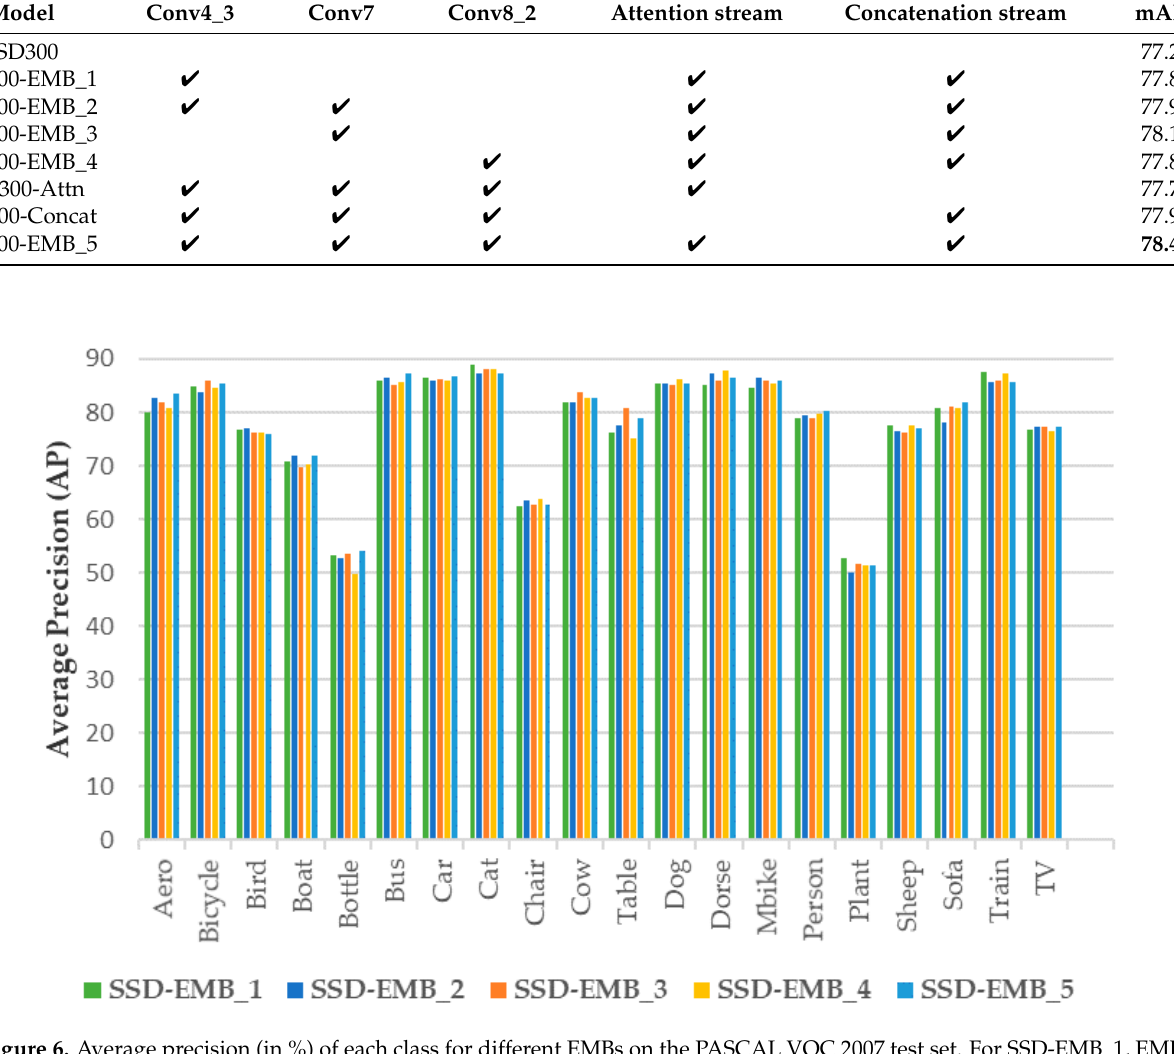
Figure 6. Average precision (in %) of each class for different EMBs on the PASCAL VOC 2007 test set. For SSD-EMB_1, EMB was applied to Conv4_3. For SSD-EMB_2, EMB was applied to Conv4_3 and Conv7. For SSD-EMB_3, EMB was applied to Conv7. For SSD-EMB_4, EMB was applied to Conv8_2. For SSD-EMB_5, EMB was applied to Conv4_3, Conv7, and Conv8_2.